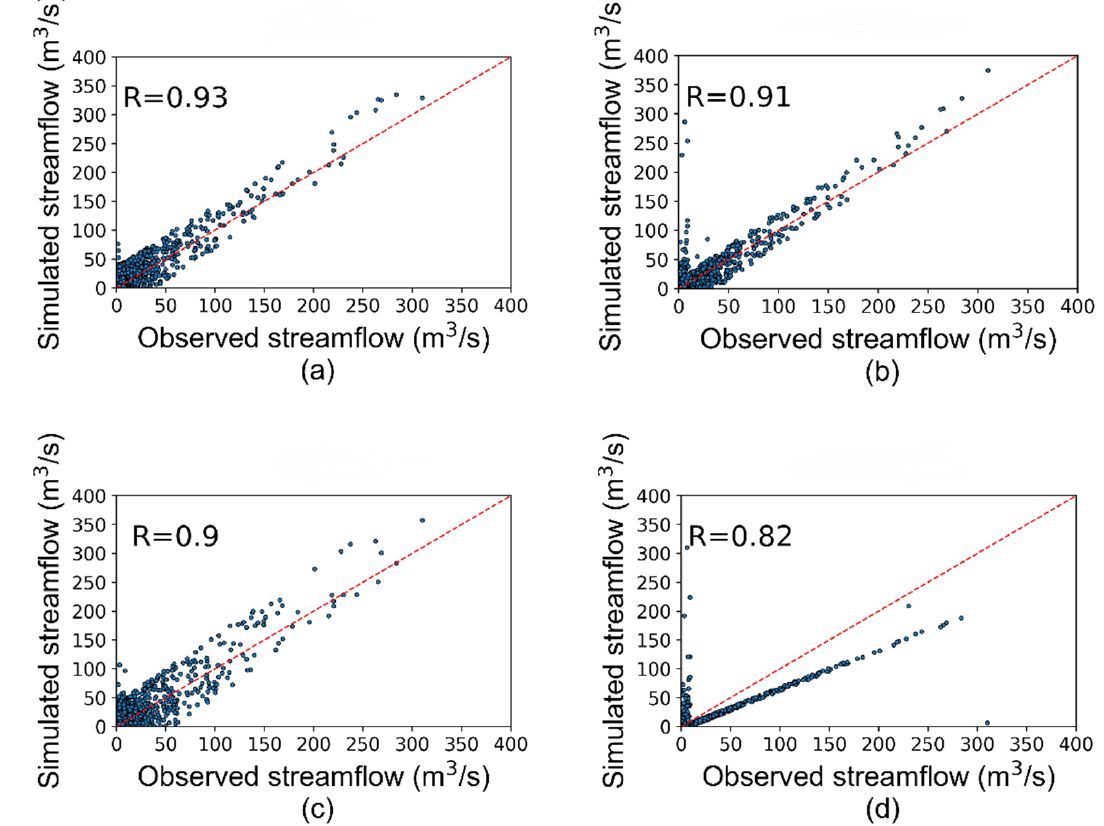
Figure 6. The scatter plots indicate the accuracy evaluation in the validation period: ( a ) LSTM model; ( b ) SVR model; ( c ) ELM model; ( d ) HEC-HMS model. Table 3. Statistical measures of streamflow simulation during the calibration and validation phases at the daily scale. The bold values represent the best statistics among all the models. Calibration Validation Model RMSE R